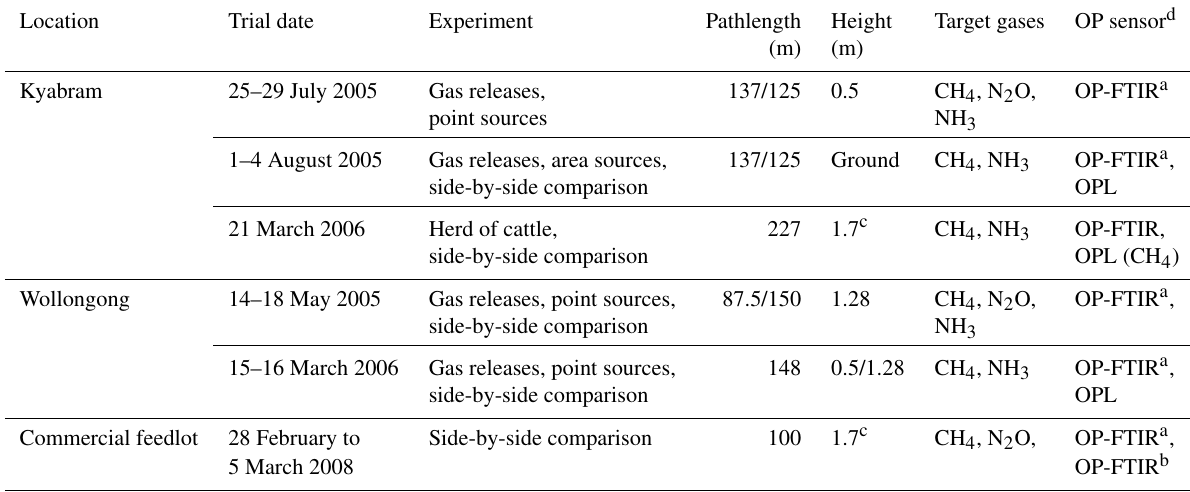
Table 1. Summary of field measurements at Kyabram, Wollongong, and the Victorian feedlot. Target gases, instrumentations used for the studies, and study durations are also shown.